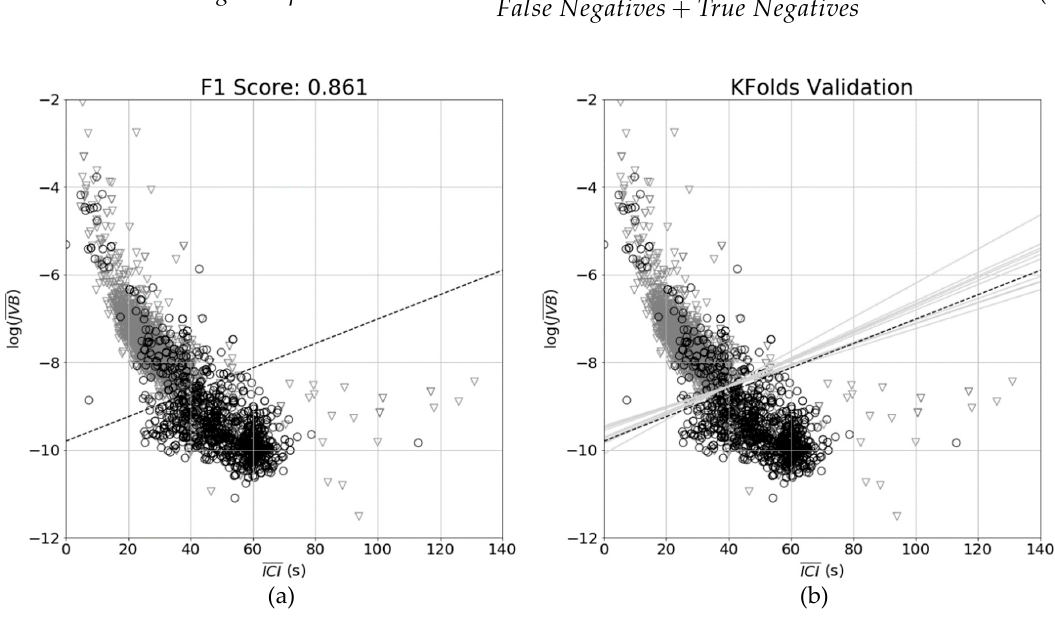
Figure 13. The Support Vector Machine (SVM) model: ( a ) the linear SVM decision boundary indicated by the black dashed line with the collar classification of rumination for each point (BLACK CIRCLES: rumination, GREY TRIANGLES: non-rumination); ( b ) the decision boundary for each of the folds shown by light grey lines.